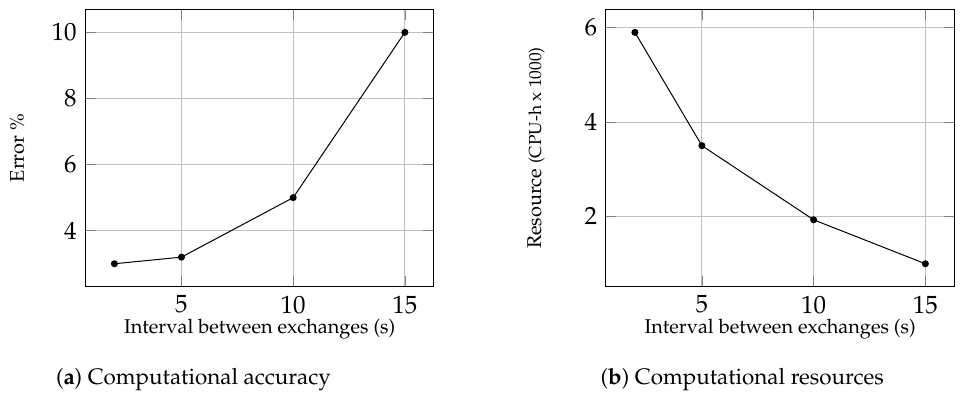
Figure 8. Sensitivity study of the effect of update frequency on the accuracy and speed of the